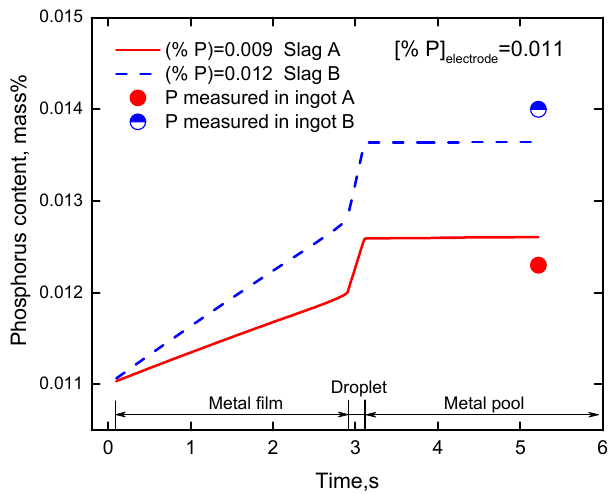
Figure 8. Effect of P content in slag on P content in ingots under the same P content in the electrode.